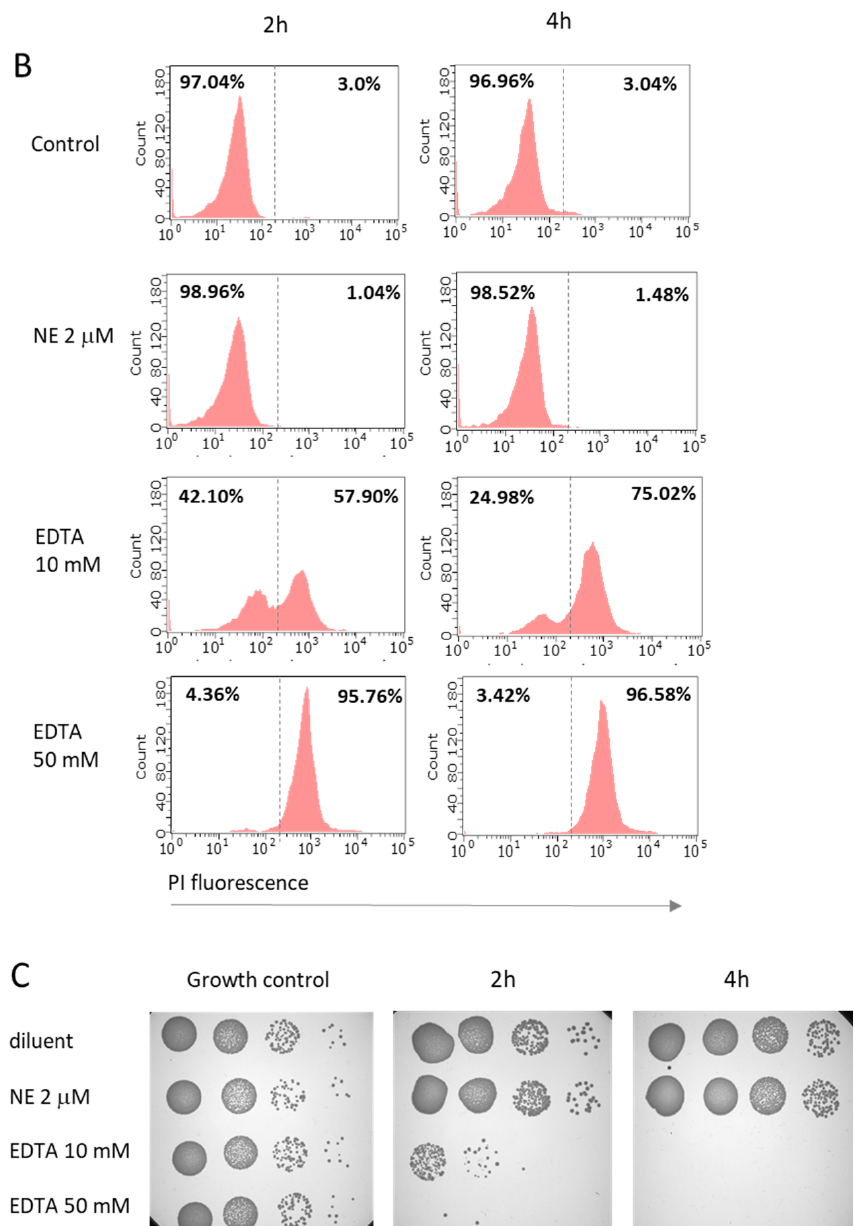
Figure 2. The lack of bactericidal and permeabilizing activity of neutrophil elastase (NE) against M. catarrhalis Mc6 . ( A ) TEM visualization of bacteria treated with NE. Mc6 were incubated (4 h, 37 °C) with 2 µM NE (middle panel). The negative control was bacteria incubated in diluent only (upper panel), and the positive control was bacteria incubated in the presence of 50 mM EDTA (lower panel). White arrows indicate membranes (outer and inner); black arrows denote lipooligosaccharide. Red arrows indicate changes in disorganization/destabilization of marked structures. TEM images for control and NE, magnification ×22,000; for EDTA, magnification ×16,000. ( B ) Flow cytometry analysis of membrane permeability. Mc6 after 4 h of NE treatment was incubated with 6 µM PI for 15 min at RT and the fluorescence was measured using red fluorescence channel with Guava EasyCyte (Merck). Negative controls were untreated bacteria with PI, and positive controls were bacteria treated with 10 mM and 50 mM EDTA. Representative histograms show the fluorescence intensity of an experiment derived from 3 independent biological replicates. ( C ) Spot plate test visualization of the bacterial growth (dilutions: 10 − 1 , 10 − 2 , 10 − 3 , 10 − 4 ) following NE and EDTA treatment at time 0, 2 h, and 4 h. Spot tests were performed in parallel with cytometric